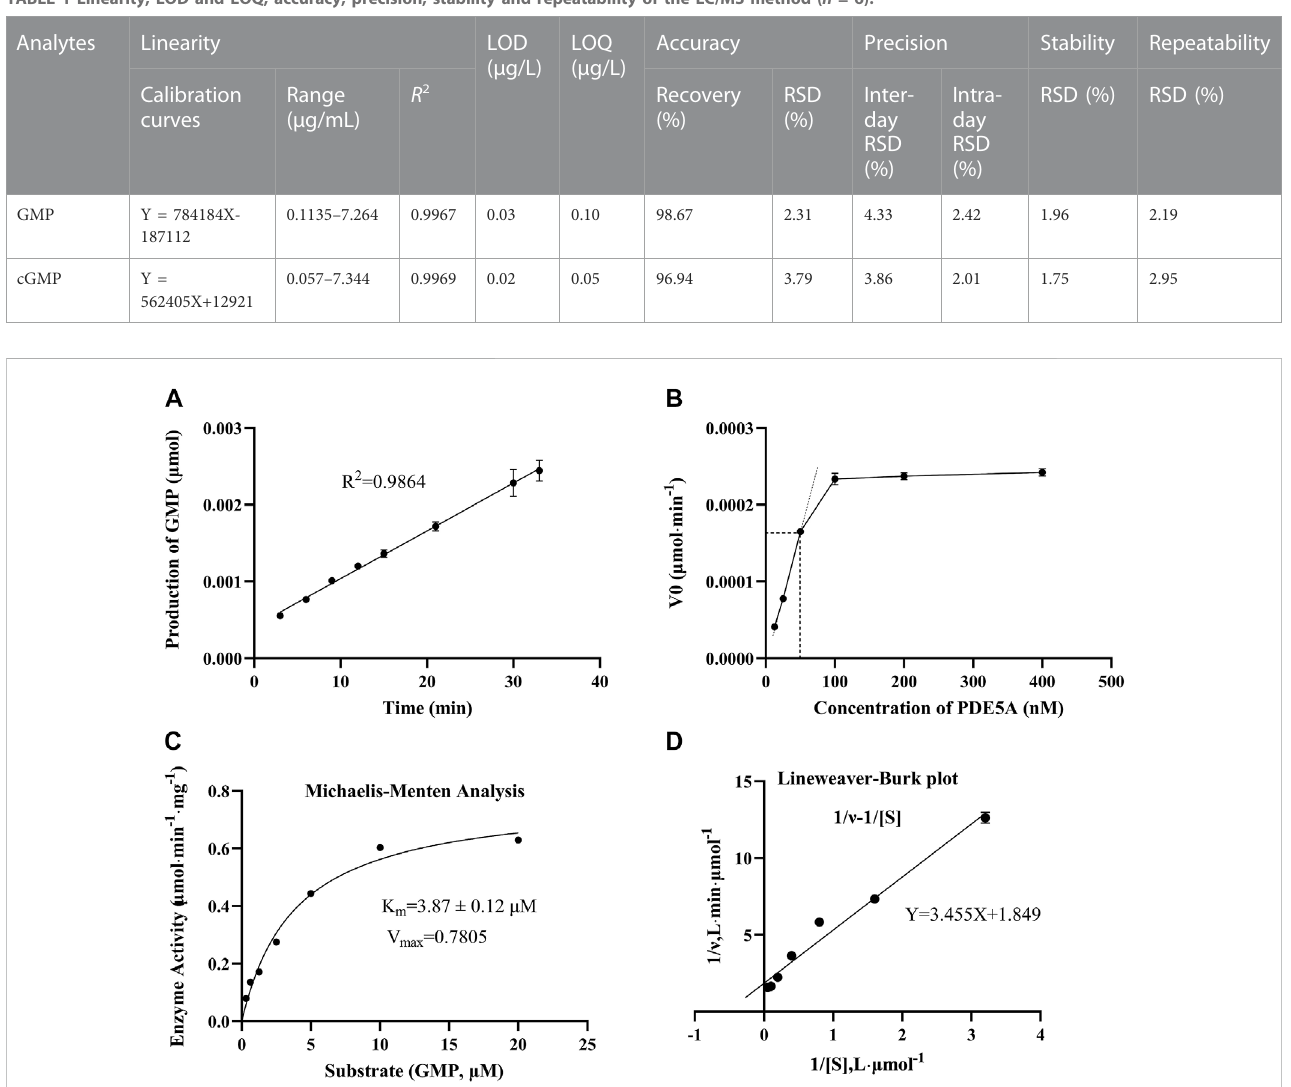
TABLE 1 Linearity, LOD and LOQ, accuracy, precision, stability and repeatability of the LC/MS method ( n = 6).